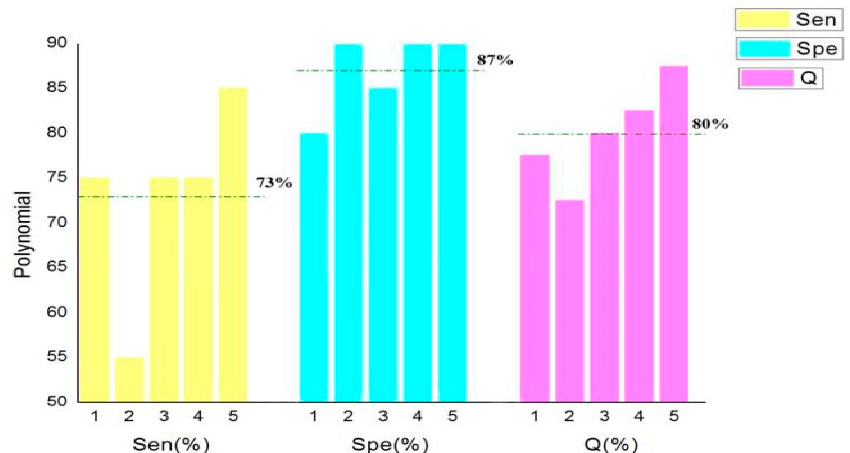
Figure 5. Cross-validation results of polynomial kernel function.